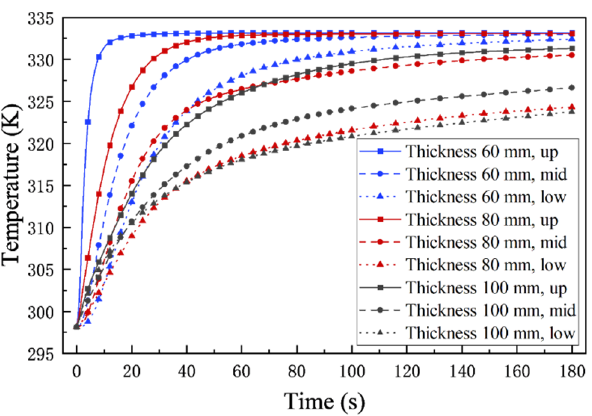
Figure 10. Overall average temperature of the heaped tobacco strips models.